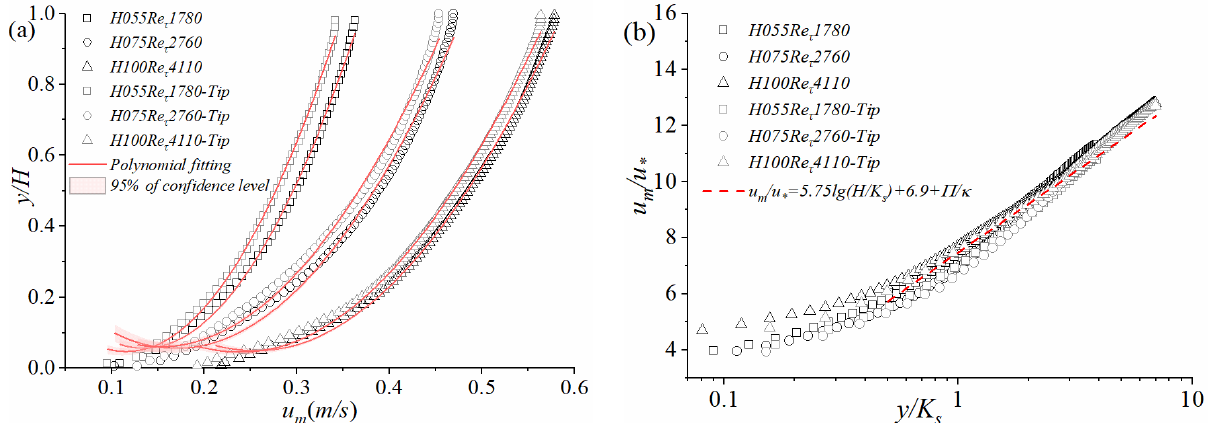
Figure 3. Time-averaged velocity profiles at different flow cases (Tip indicates that the starting point of the measurement is at the top of the pebble particles):(a) the time-averaged absolute velocity profiles; (b) the normalized velocity profiles processed by the friction velocity.